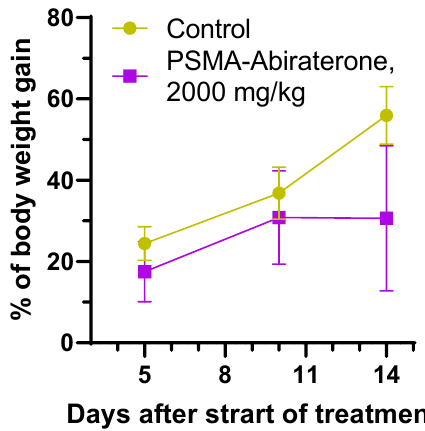
Figure 2. Body weight dynamics of mice after single-dose oral administration of PSMA-Abi (2000 mg/kg).